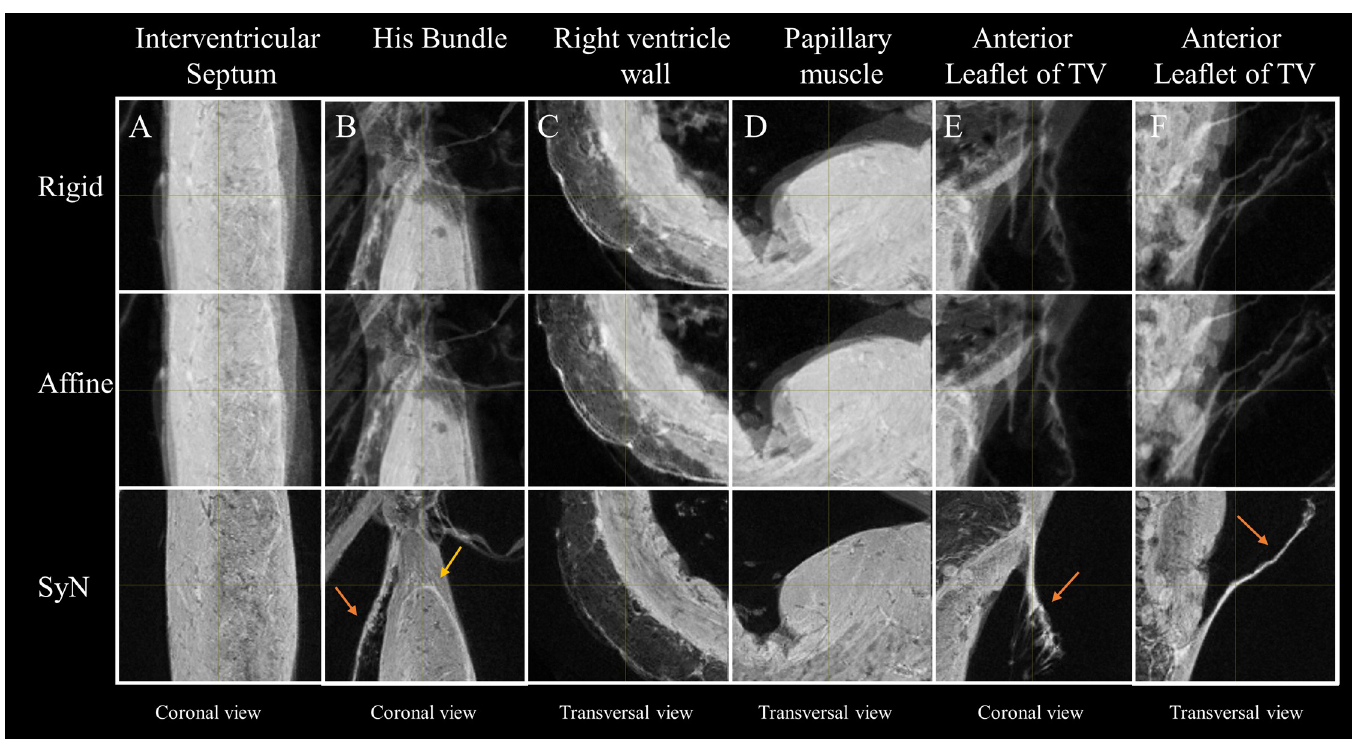
Fig 3. Impact of the transformation model during the registration on the anatomical template in five different regions. Zoom-view in the IVS (A), near the division of the His bundle in left and right bundles (B), in the RV wall (C), in the posterior papillary muscle of the LV (D) and on the anterior leaflet of the tricuspid valve (TV) (E and F) using Rigid (top row), Affine (middle Row), SyN (bottom row) transformation models, The misregistration areas visible using Rigid and Affine transformation are less pronounced using SyN for the large or small structures like the conduction system (yellow arrow) or the leaflets of the valve (orange arrows).